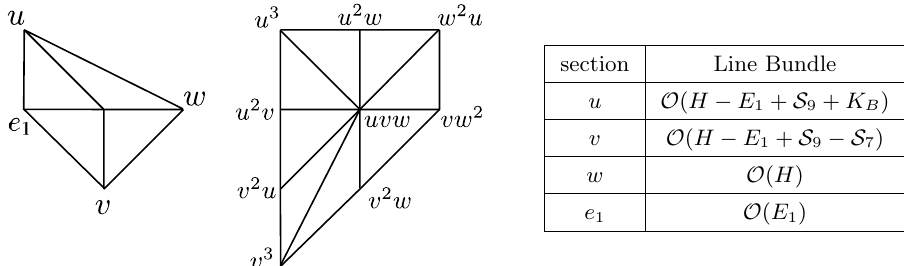
Figure 7 . The polytope F 3 and its dual. The table on the right provides the line bundle classes for the coordinates in P F 3